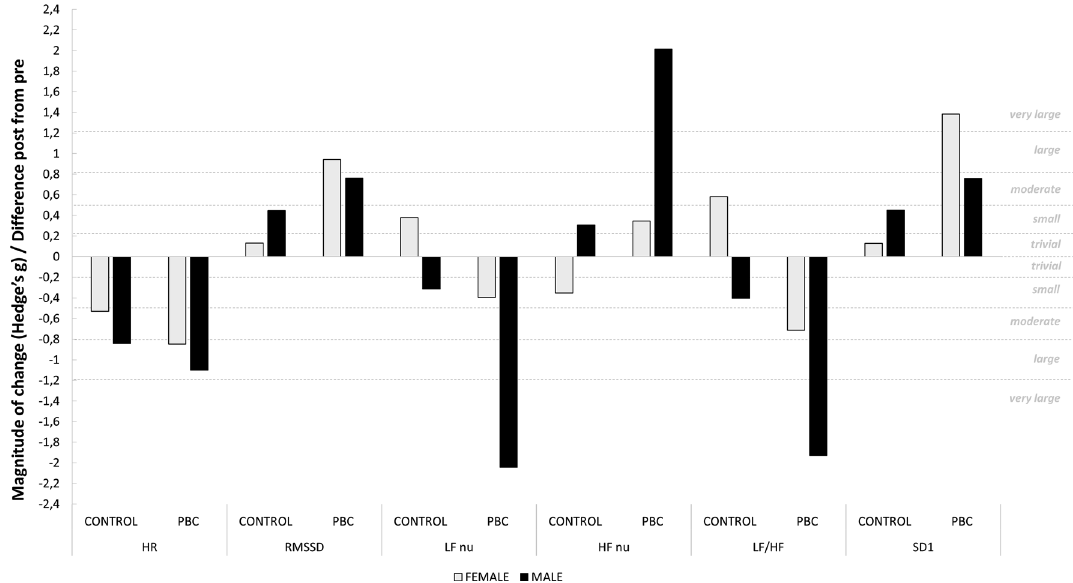
Figure 4. Magnitude of change of heart rate variability indices from prior to PBC (partial body cryotherapy) and control conditions.